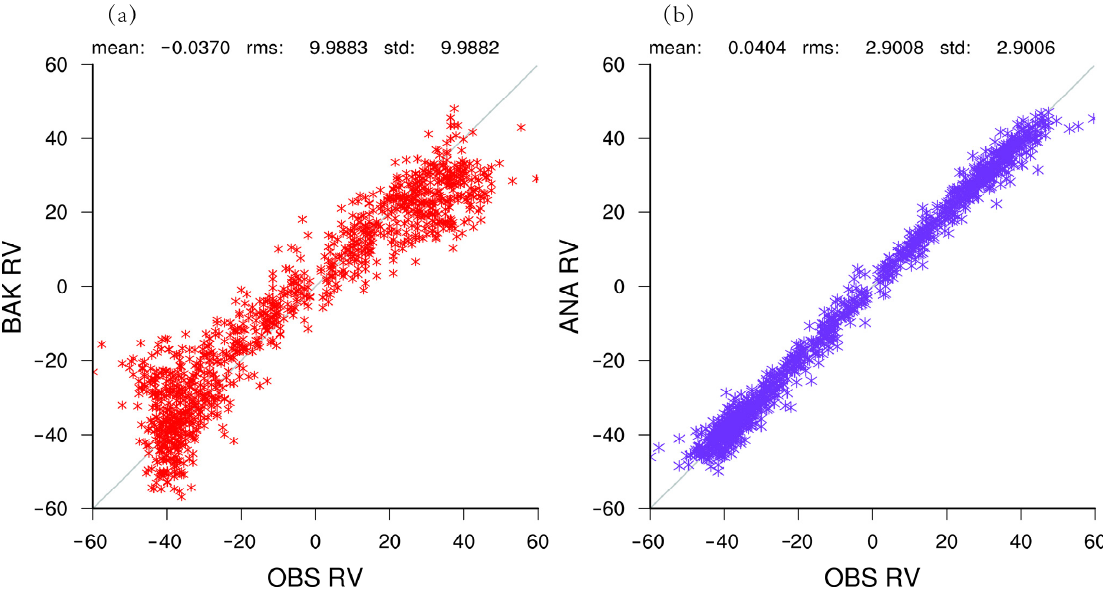
Figure 6. Scatter of radar radial velocity in ( a ) observation and background, ( b ) in observation and analysis for experiment DA_Radar at 0000 UTC 13 September 2008.